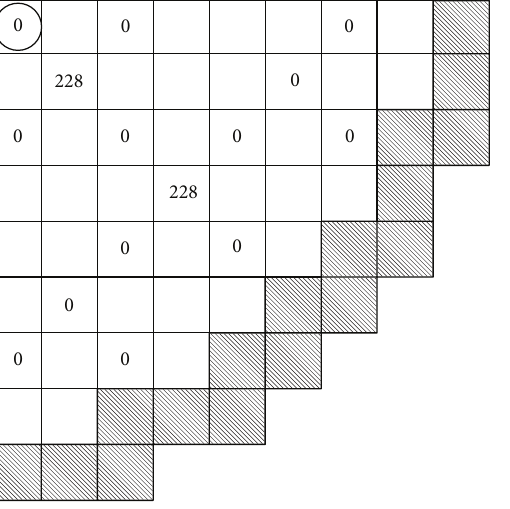
Figure 2: The initial control rod positions for case A1 (circled position is ejected).